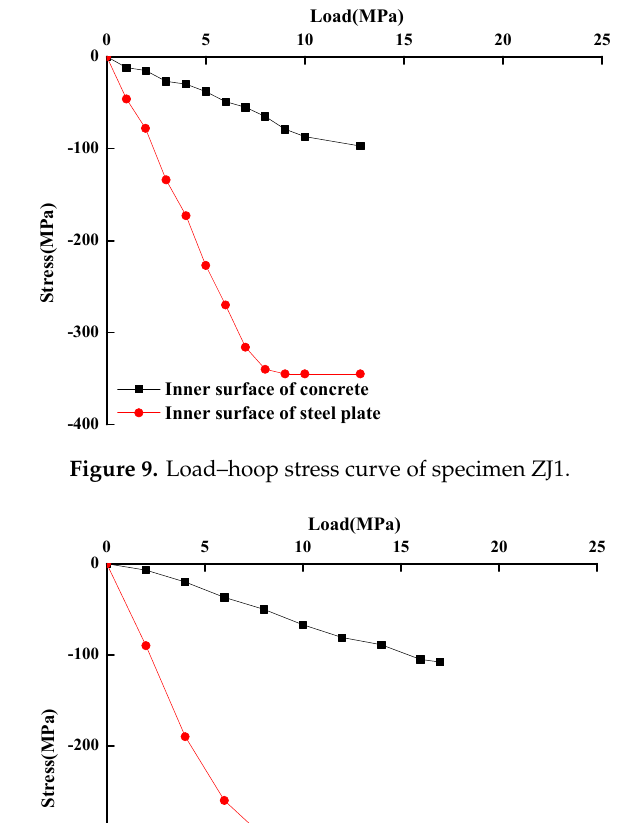
Figure 11. Load–hoop stress curve of specimen ZJ6. Figure 12. Load–hoop stress curve of specimen ZJ8. As demonstrated in Figures 9–12, when the load was small, the shaft lining structure displayed well-behaved linear elastic characteristics. The stress on the steel plate and the concrete layer both increased nearly linearly as the load increased. As the external load increased, the stress increased at an increasing rate, deviating from the linear pattern. Thus, the shaft lining structure entered the plastic stage. As the specimen entered the plastic deformation stage, the inner steel plate did not buckle and fail because of the anchoring action of the anchor clamps. The inner steel plate, together with the outer steel plate, strongly constrained the concrete layer between them and prevented this layer from undergoing deformation or crack initiation. As a result, the compressive strength of the concrete increased significantly, and this material displayed notable plastic properties [30]. Compared with the test results of the other shaft lining models, a similar change rule of stress was shown. By analyzing Figures 9–12, we observed that the maximum hoop stress on the shaft lining concrete in the specimens ZJ1, ZJ4, ZJ6, and ZJ8 reached 97.3 MPa, 108.0 MPa, 122.6 MPa, and 132.7 MPa, respectively, during the loading process until failure, much higher than the compressive strength determined from cube tests performed on the concrete used to fabricate the specimens (61.7 MPa, 60.2 MPa, 70.6 MPa, and 65.8 MPa, respectively). This finding suggests that the concrete in this type of shaft lining structure is under triaxial compressive stress and, consequently, that its actual compressive strength is significantly higher than its uniaxial strength. This type of composite shaft lining structure is enhanced by this mechanism.